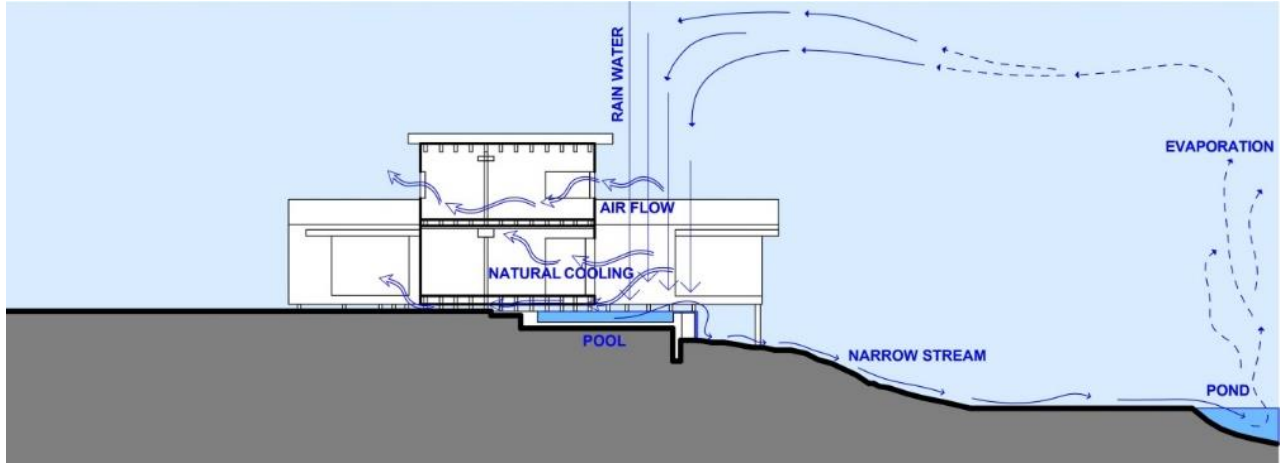
Figure 10. Karuizawa summer house—section, natural ventilation and water cycle = eco-friendly, sustainable